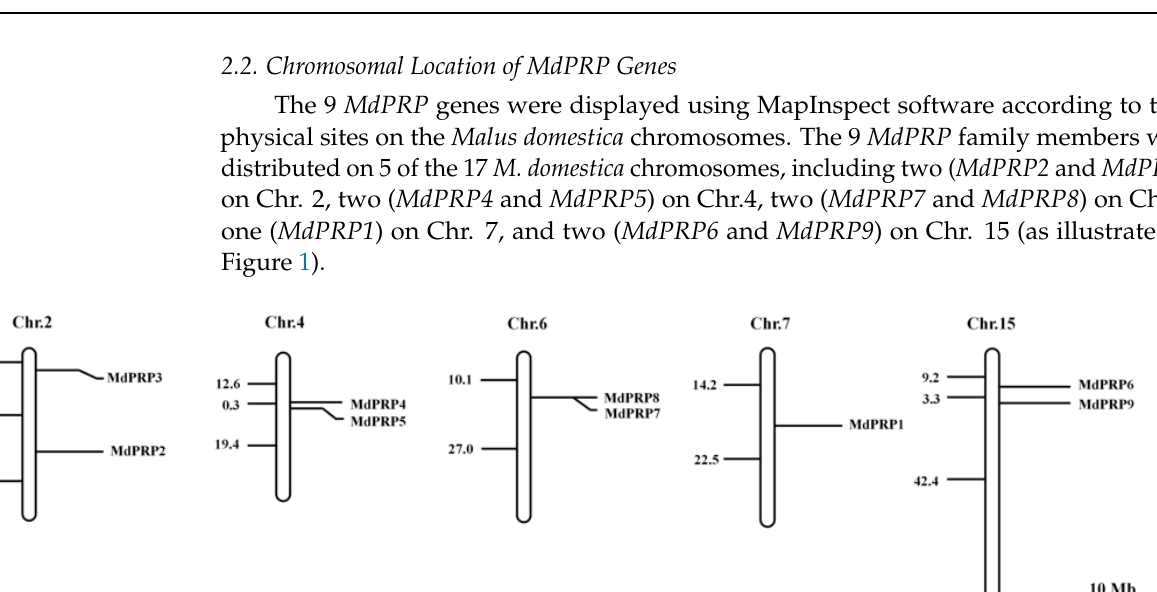
consisted of a long cysteine-rich hydrophobic domain (as illustrated in Figure 2). There are eight cysteines in the cysteine-rich hydrophobic domain. The spacing between the eight cysteines may be necessary to form disulfide bonds within or with other proteins [18,19]. Conservative spacing of L was also found in these PRP proteins and may be related to the formation of leucine zipper motifs [20]. These results indicate that PRP family protein sequences are highly conserved in